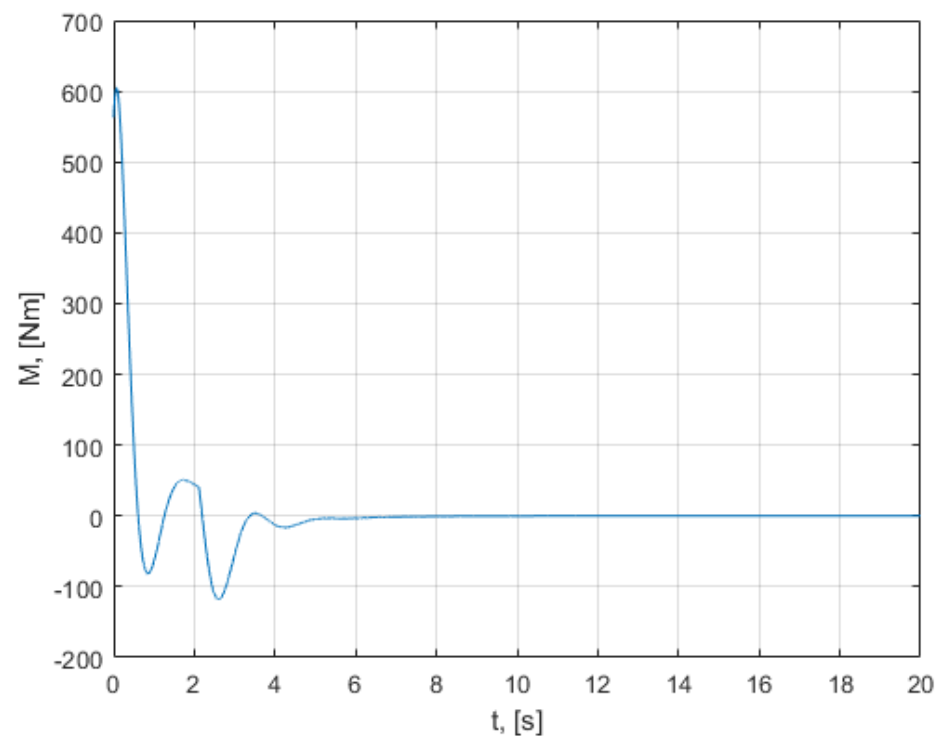
Figure A6. The speed response of position control system.